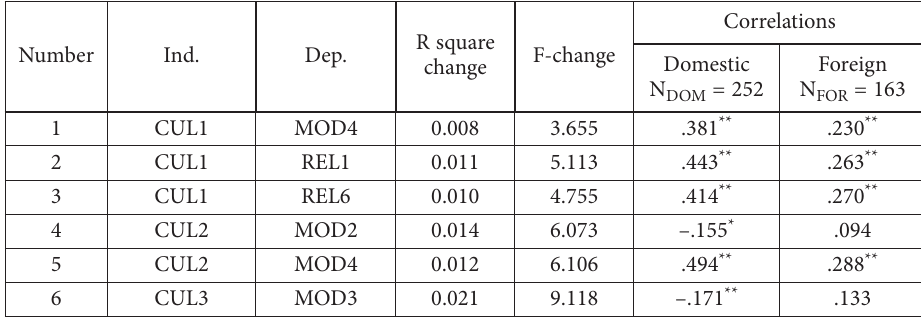
Table 5. Hierarchical regression analysis of the moderating effects of National origin of companies in observed relations (only the results where there are moderating effects) Number Ind. Dep.